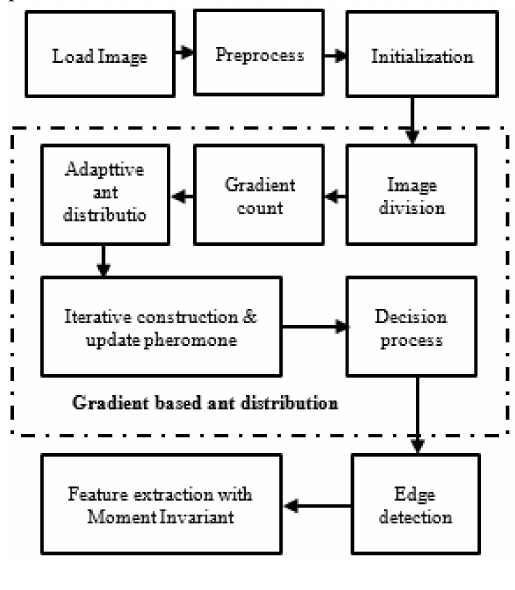
Figure. 1. Flow Mechanism of Adaptive